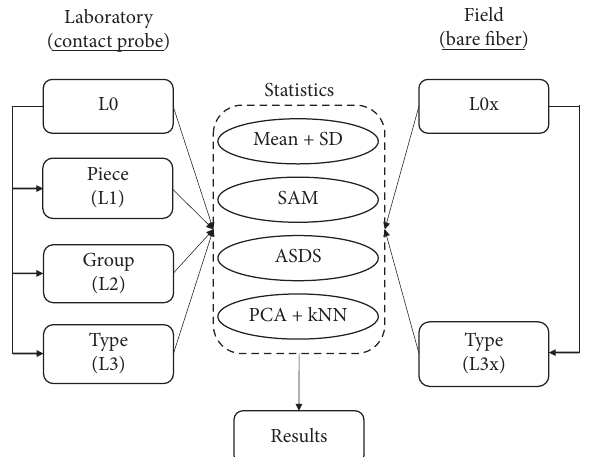
Figure 2: Schematic representation of the statistical analysis.